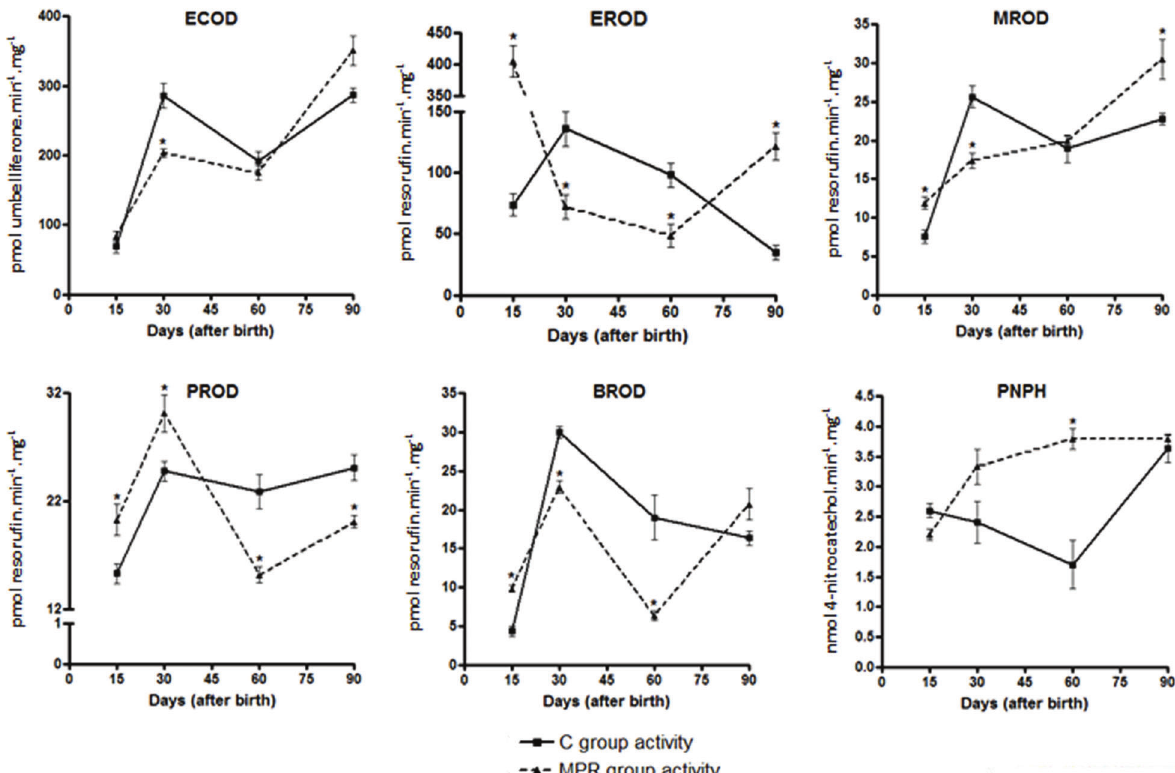
Figure 3. Analysis of ethoxycoumarin – O-deethylation (ECOD), ethoxyresoru fi n-O – deethylation (EROD), methoxyresoru fi n – O- demethylation (MROD), pentoxyresoru fi n – O – depentylation (PROD), benzyloxyresoru fi n – O-debenzylation (BROD) and p-nitrophenol hydroxylation (PNPH) activities measured in liver microsomes from 15-, 30-, 60- and 90- day-old offspring from dams fed either a 0% protein (MPR groups) or a standard diet (C groups) during the fi rst ten days of lactation. Data are reported as median and standard deviation of three biological replicates (catalytic activities data derived from three independent pools of 6 male rats from each group, i.e., N=3). *P o 0.05 for MPR samples compared to their C counterpart samples (Student ’ s t